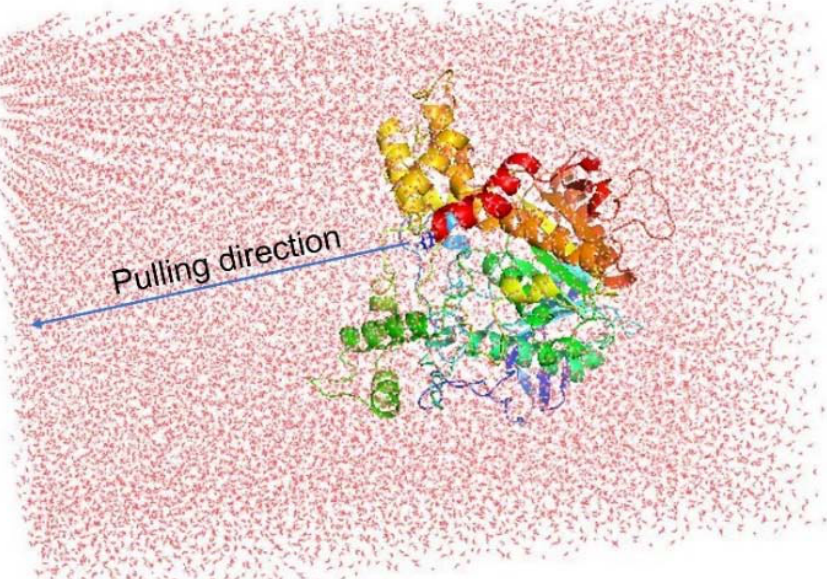
Figure 6. Computational modeling of FPL calculations. The pulling pathway is aligned along the Z − axis.